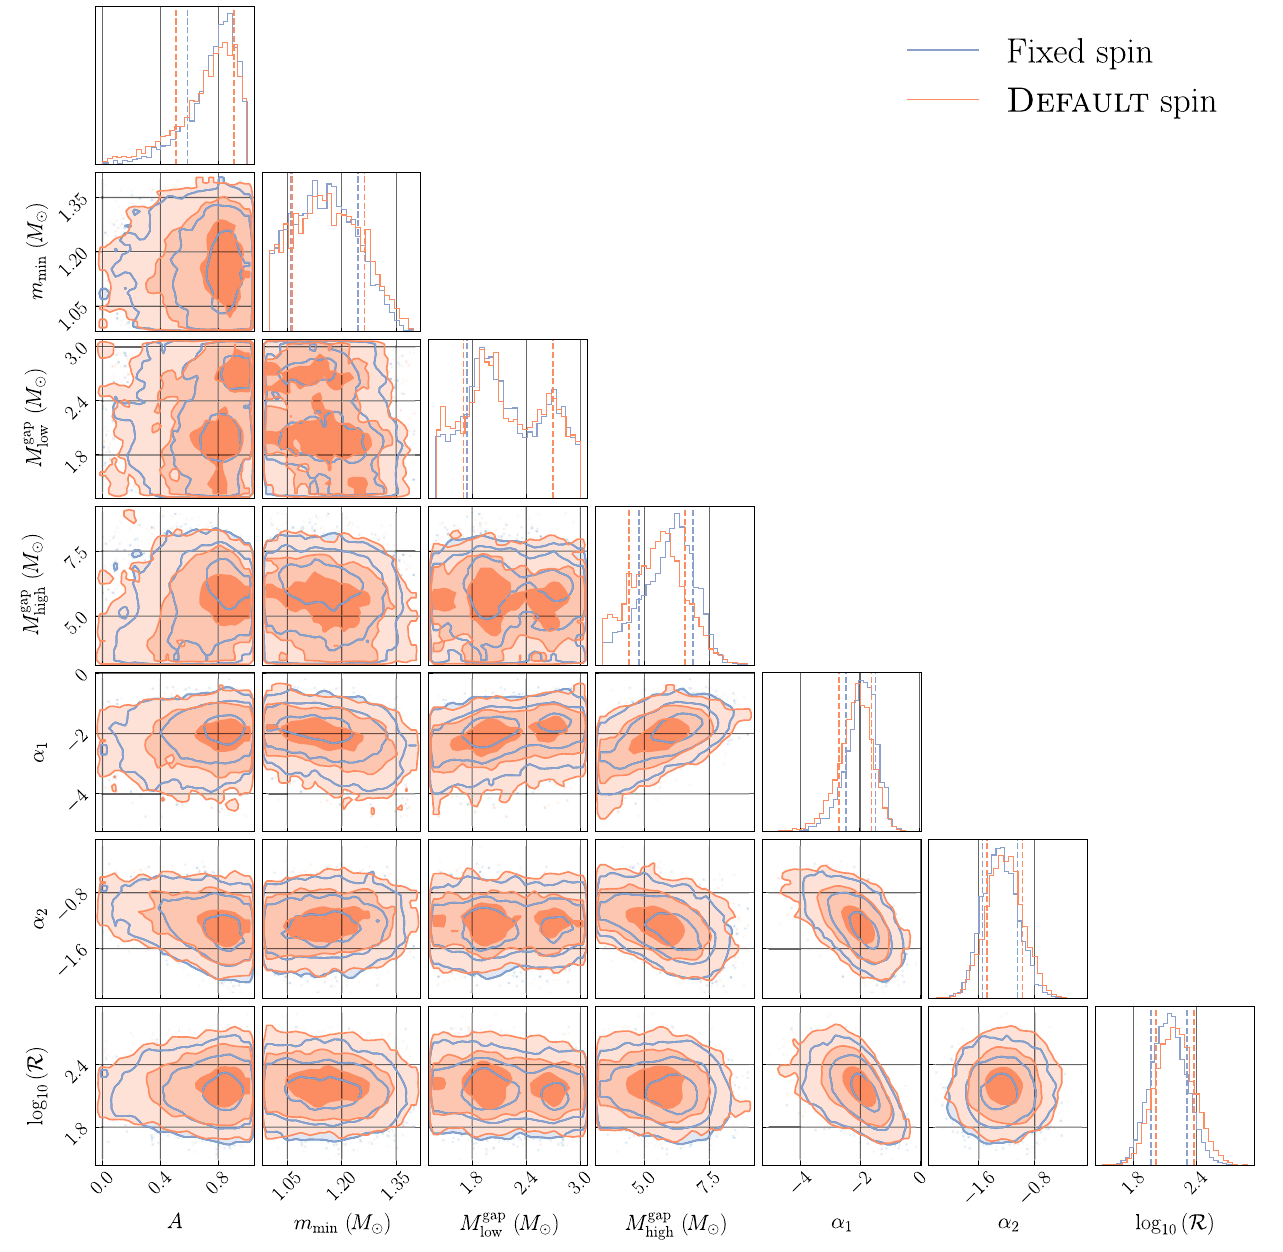
FIG. 24. Corner plot of inferred PDB mass and rate hyperparameters under an analysis that fixes the spin distribution (blue) and simultaneously fits the spin distribution using the D EFAULT model (orange). The fit-spin hyperposterior is slightly shifted and widened when compared to the fixed-spin case, but all changes are within statistical